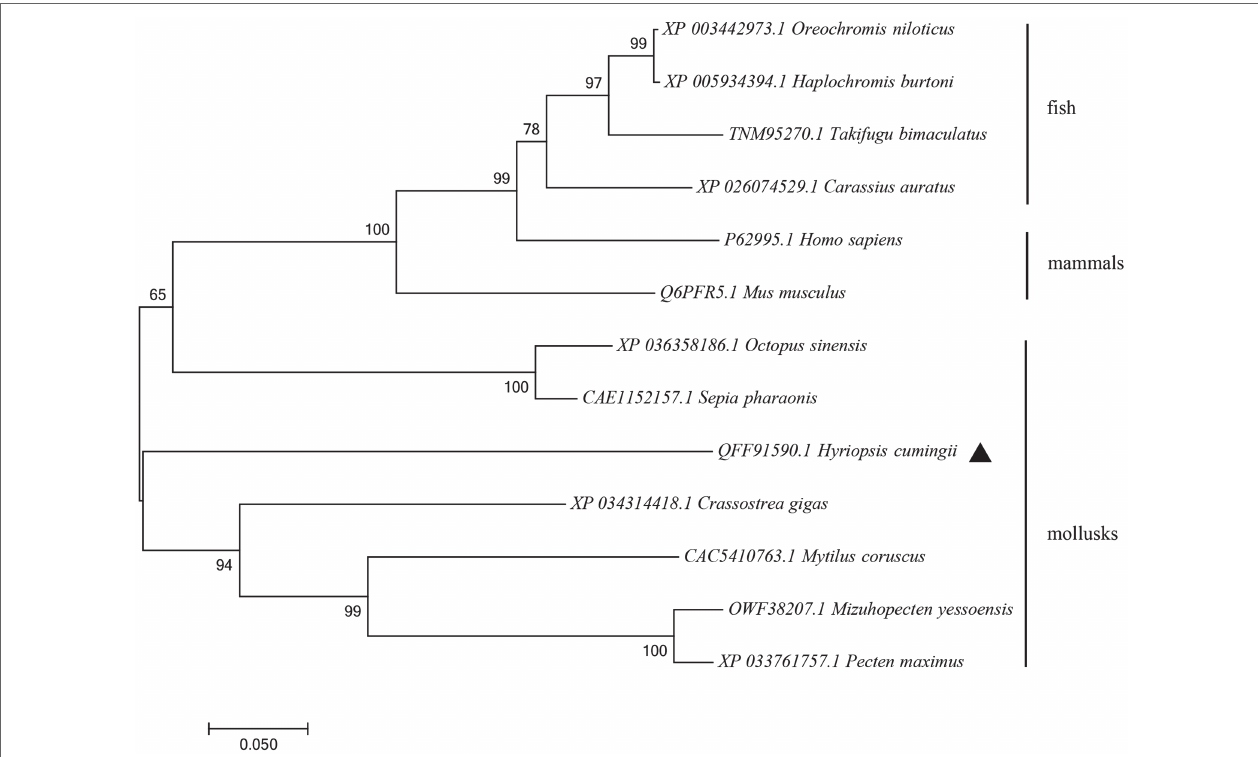
FIGURE 3 | NJ phylogenetic tree of amino acid sequences of Hctra-2 gene in different species. NJ law contribution was made by MEGA6.0; the number on the node was bootstrap test confidence value repeated 1,000 times.